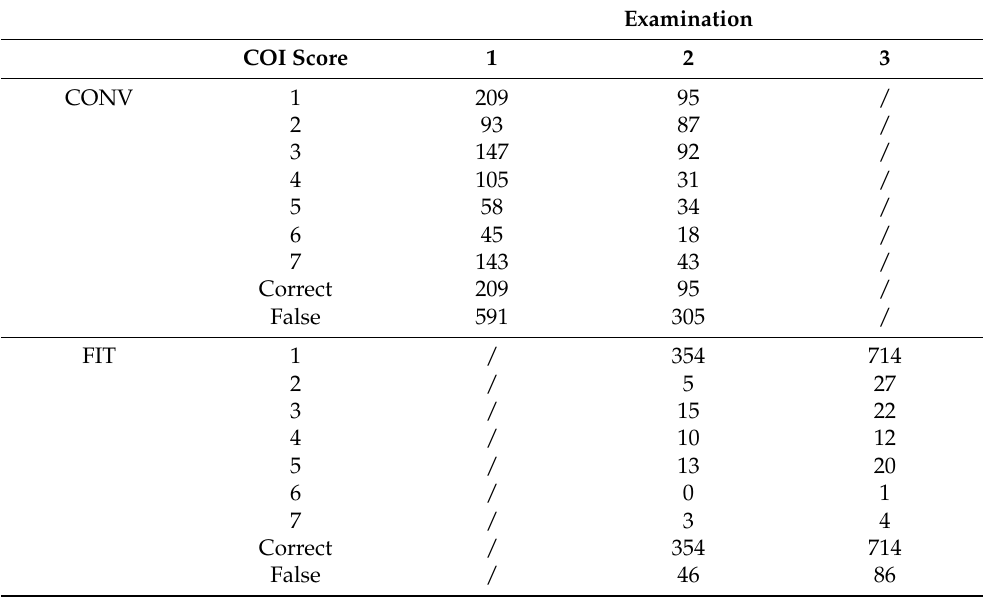
Table 2. Distribution of correctness of identification (COI) grades 1–7 and their dichotomous catego- rization as “correct” (score 1) and “false” (score 2–7) for examination 1 (CONV), 2 (CONV and FIT), and 3